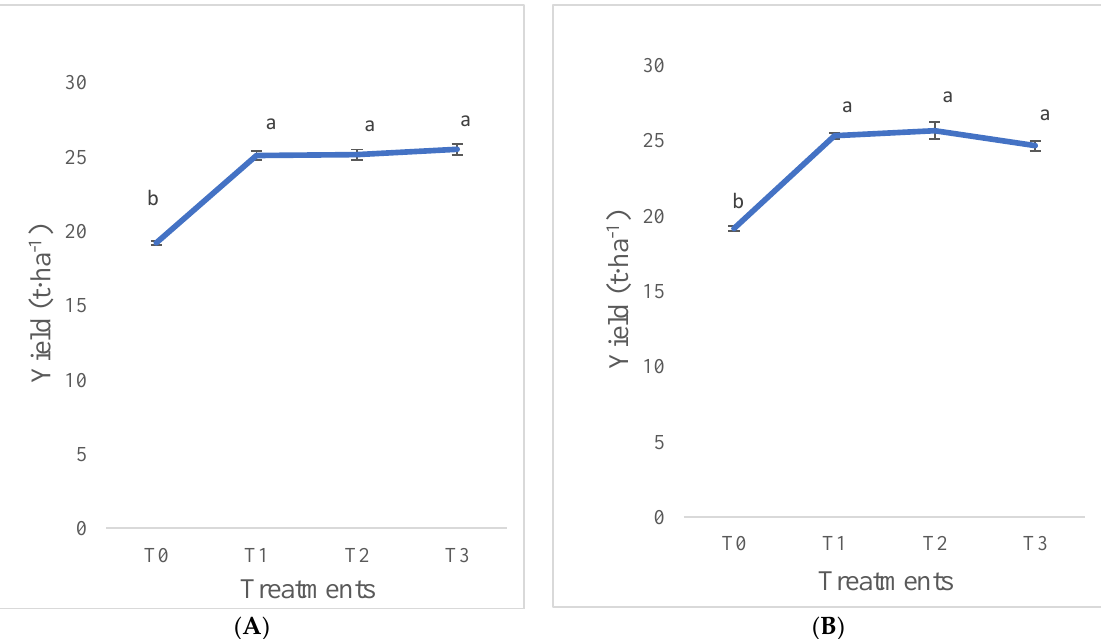
Figure 5. Lucerne nodules number under inoculation with liquid formulation (T0, T1, T2, and T3) of Sinorhizobium meliloti in climatic zone ( A ) = Bronkhorspruit/Gauteng and ( B ) = Hart- beesfoein/NorthWest Province). Bars sharing a letter are not significantly different (Lsd Zone A) = 9.126 and (Lsd Zone B) = 7.418. Data are means ± standard errors.